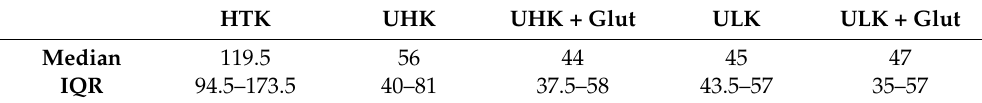
Table 4. Rebeating times (seconds) after graft flush and storage with HTK and Unisol-based perfusates. HTK UHK UHK + Glut